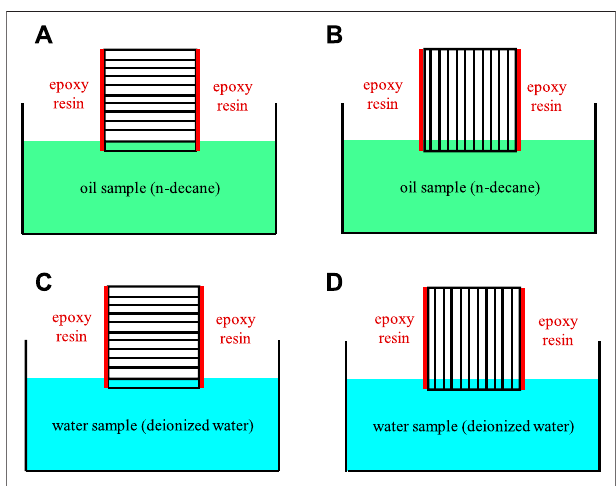
FIGURE 3 | Schematic diagram of samples with epoxy resin coating in the spontaneous imbibition experiment (black thin parallel lines refer to the shale foliation).